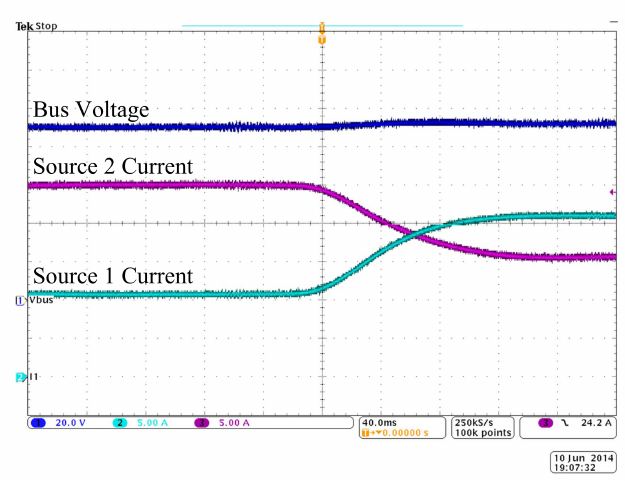
Figure 9. Hardware-in-the-loop results with optimal multidimensional droop control during a step change in wind speed: Ch1 bus voltage; Ch2 Source 1 current; Ch3 Source 2